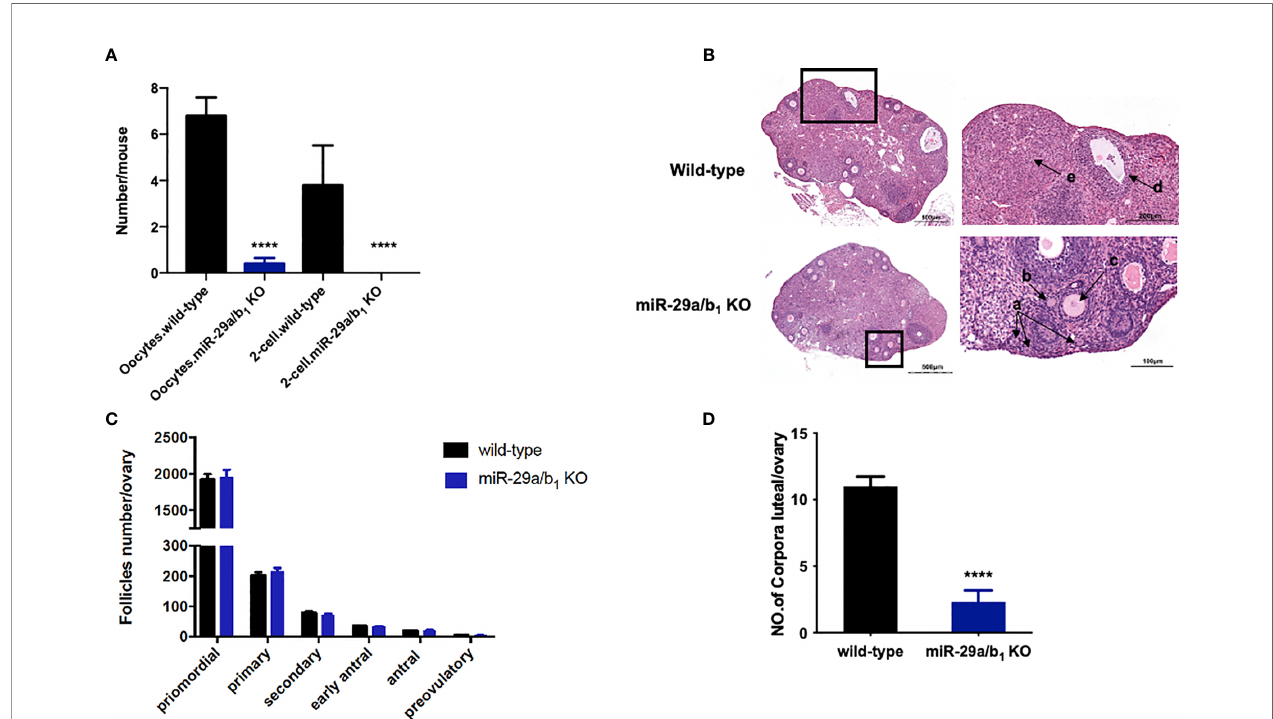
FIGURE 3 | Lacking of miR-29a/b 1 impairs ovulation in females. (A) Numbers of oocytes and 2-cell embryos in wild-type and miR-29a/b 1 KO mice during natural ovulation (n=5). (B) Histological sections of ovaries stained with haematoxylin and eosin (H&E) in wild-type and miR-29a/b 1 KO mice. Corpora lutea (CLs) and follicles at different stages are shown at higher magni fi cation and denoted with arrows. a: Primordial follicles; b: Primary follicles; c: Secondary follicles; d: Antral follicles; e: Corpora lutea. (C) Numbers of follicles at different stages in ovaries from wild-type (n=10) and miR-29a/b 1 KO (n=12) mice. Primordial follicles: p=0.8931 ; Primary follicles: p=0.9802 ; Secondary follicles: p=0.6842 ; Early antral follicles: p=0.5645 ; Antral follicles: p=0.8011 ; Preovulatory: p=0.5081 , respectively. (D) Lack of corpora lutea in the ovaries of miR-29a/b 1 KO females ( p<0.0001 ). **** p <